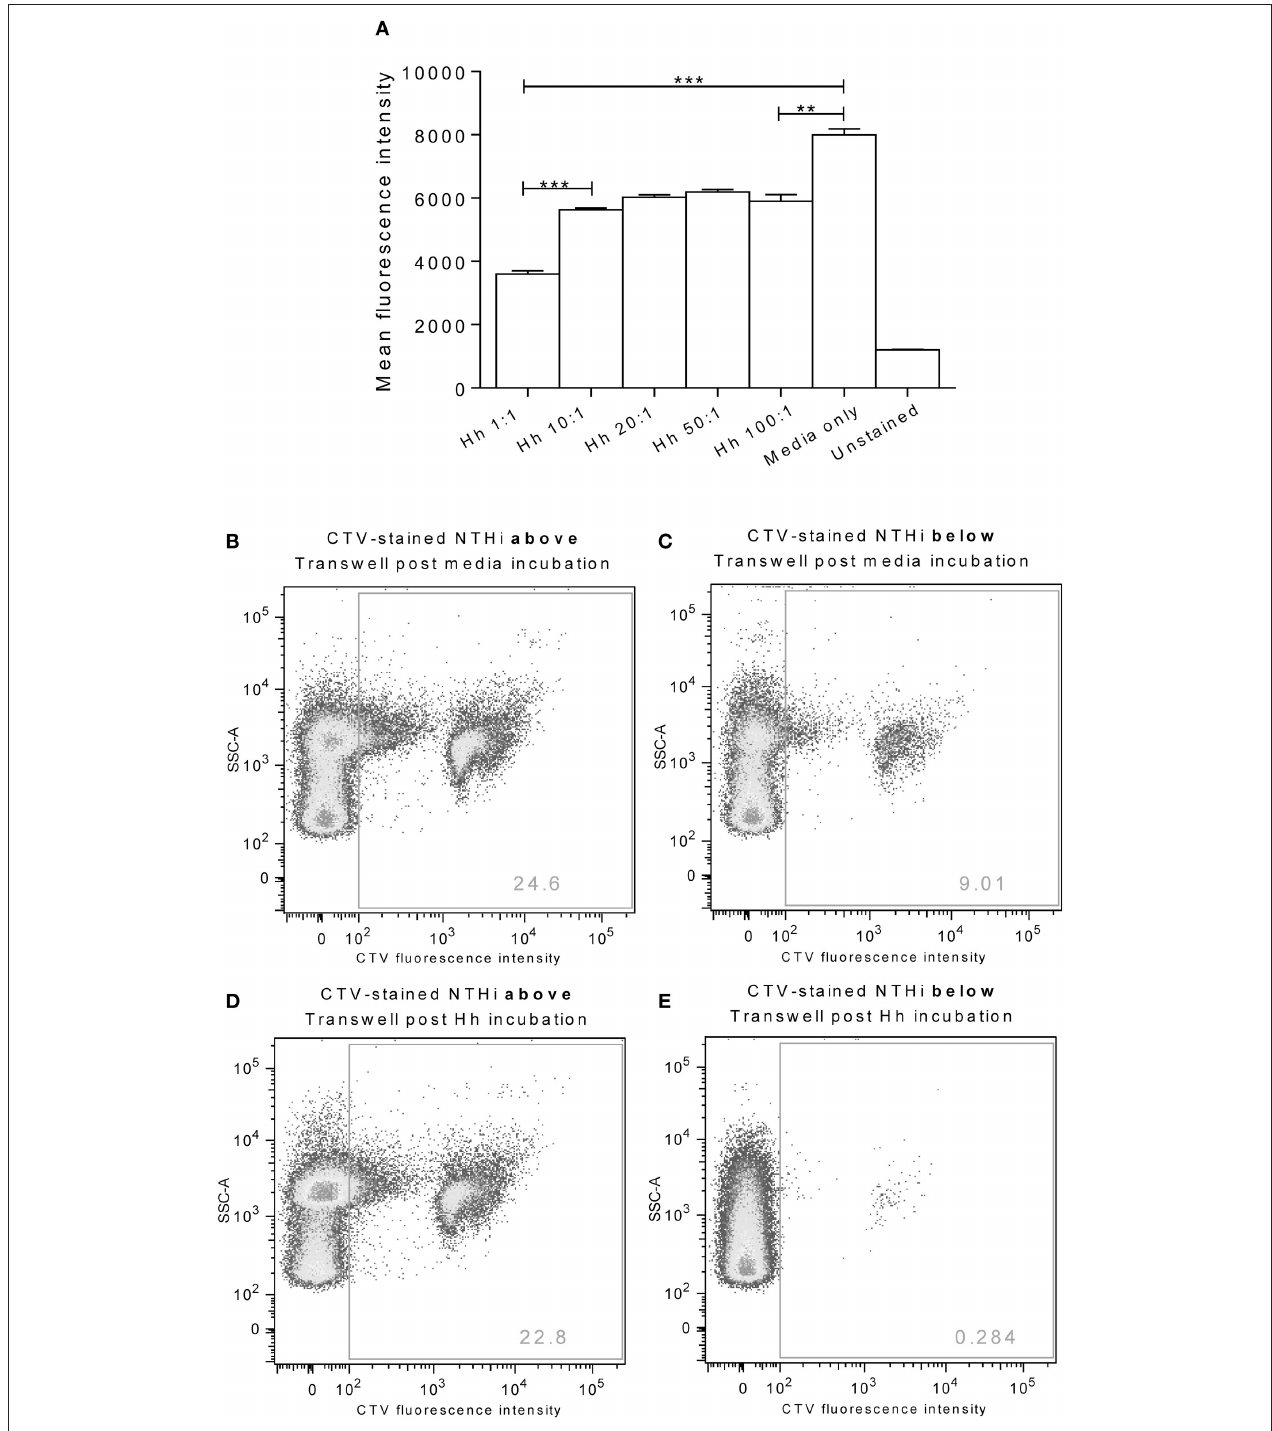
FIGURE 4 | Pre-colonization of epithelia with H. haemolyticus impacts subsequent NTHi interactions. Monolayers of D562 cells were challenged with increasing doses of H. haemolyticus 33390 or media for 1h, washed thoroughly and then challenged with 1000:1 CTV-stained NTHi86-028NP (A) . At 1h post NTHi-infection, wells were thoroughly washed, and fluorescence was measured to identify attached NTHi. Results are represented as mean ± SEM of three technical repeats. Student’s unpaired t -test was used to compare between treatments where ** p < 0.01 , *** p < 0.001 . A549 monolayers grown on Transwells were incubated with media (B,C) or 10:1 H. haemolyticus 33390 (D,E) for 1h. Monolayers were then washed with media, challenged with CTV-stained NTHi (MOI 10:1) and incubated at 37 ◦ C 5% CO 2 for a further 3h. Pre-colonization with H. haemolyticus (MOI 10:1) reduced the proportion of CTV-stained NTHi detected in the lower compartment of the Transwell ( E , 0.3%) compared with pre-incubation with media alone ( C , 9.0%).